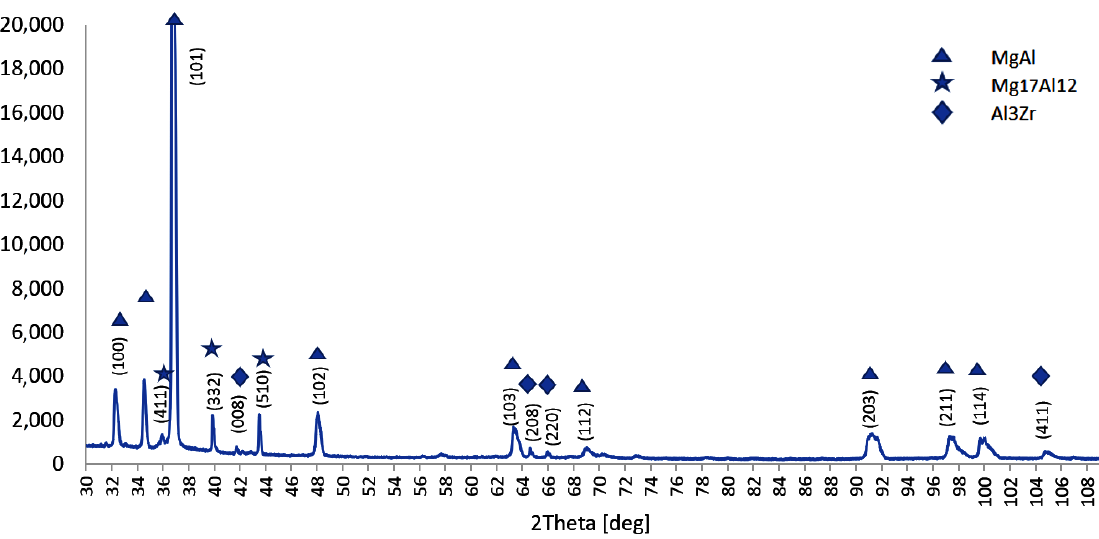
Figure 8. XRD spectra of AZ91 with 0.3 wt % of Zr. The XRD results revealed that the main phases are: α -Mg matrix (Mg – Al solid solution), β -Mg 17 Al 12 and Al 3 Zr. According to XRD analysis a small amount of the element Zr could exist in solid solution in the Mg matrix, and the excess Zr formed the Al 3 Zr phase, which is consistent with the Mg-Zr equilibrium phase diagram presented in next section.